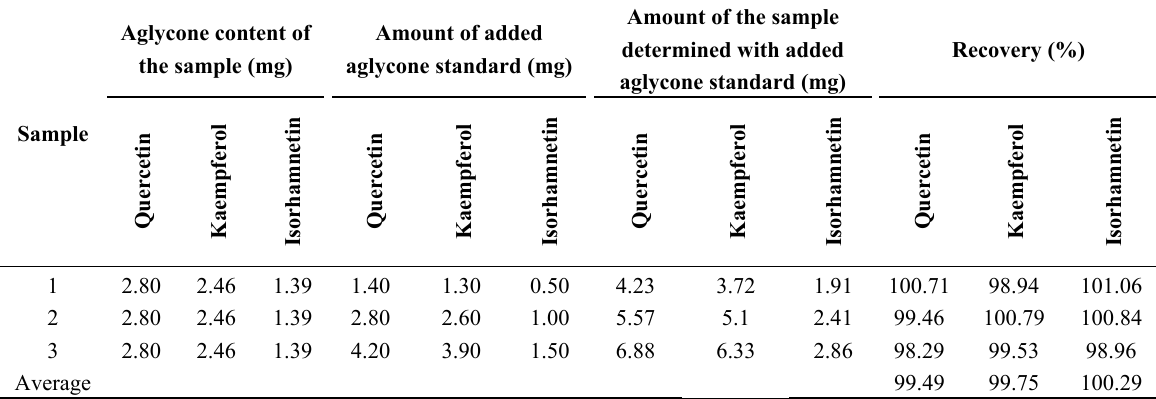
Table 3. Recovery of quercetin, kaempferol and isorhamnetin from Ginkgo foliage ( n = 3).